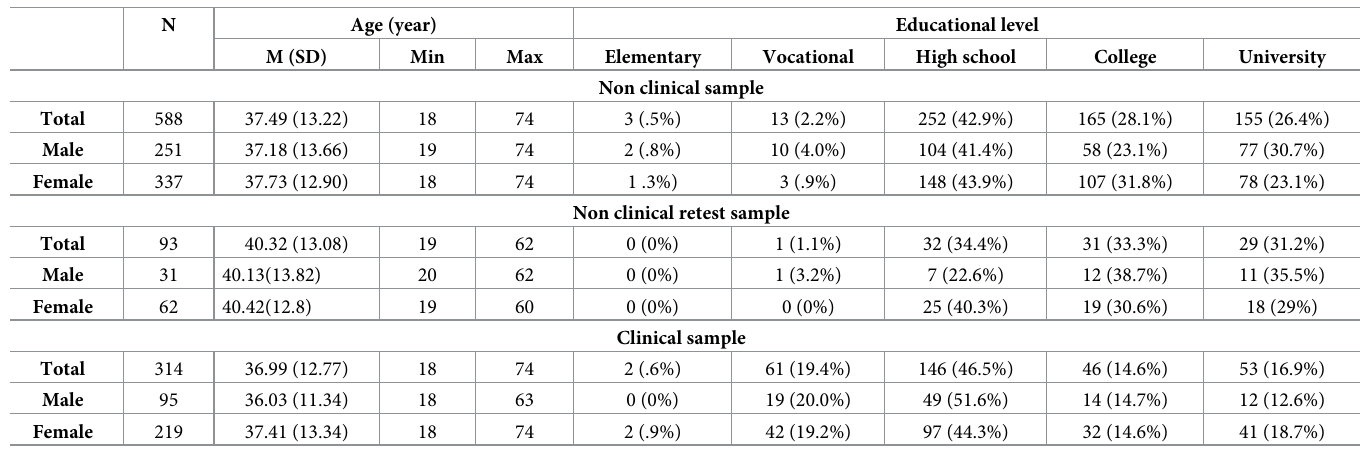
Table 3. Descriptive statistics of the